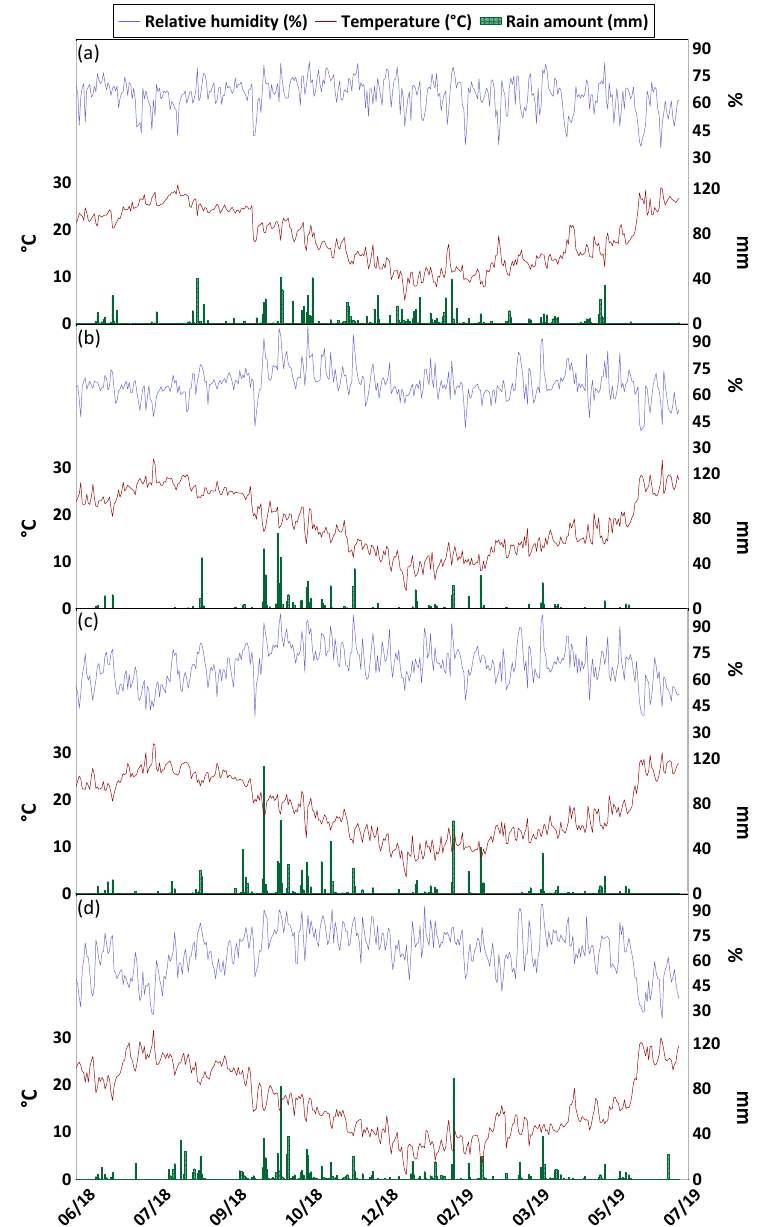
Figure 2. Temperature (°C), relative humidity (%), and rain amount (mm) at the SIAS automatic weather station of Milazzo ( a ), Augusta ( b ), Siracusa ( c ), and Palazzolo Acreide ( d ), during the study period.